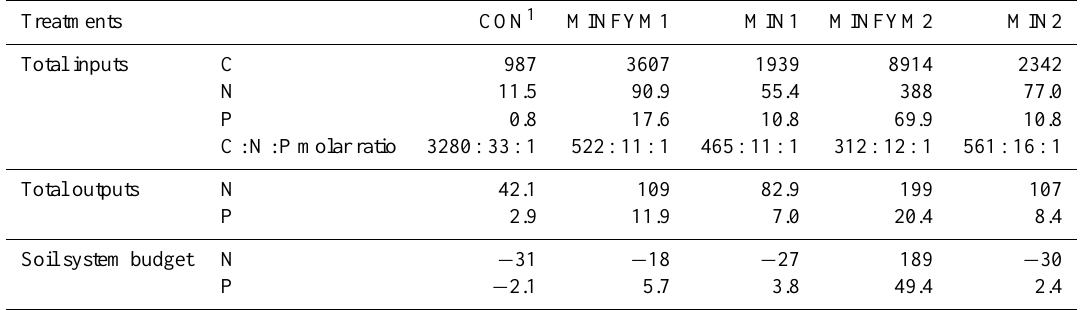
Table 2. Average C, N, and P in inputs and C:N:P molar ratios in inputs; N and P outputs; and soil system budgets (in kgha − 1 year − 1 ) for soil–plant systems subjected to different treatments in the field experiment at Saria, Burkina Faso, for the period 1975–2010. Treatments CON 1 MINFYM1 MIN1 Total inputs